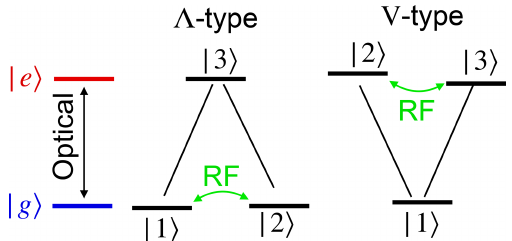
Figure 2. The most important three-level systems that allow basic optical excitation and detection of magnetic resonance. The arrows indicate the transitions coupling to optical and RF